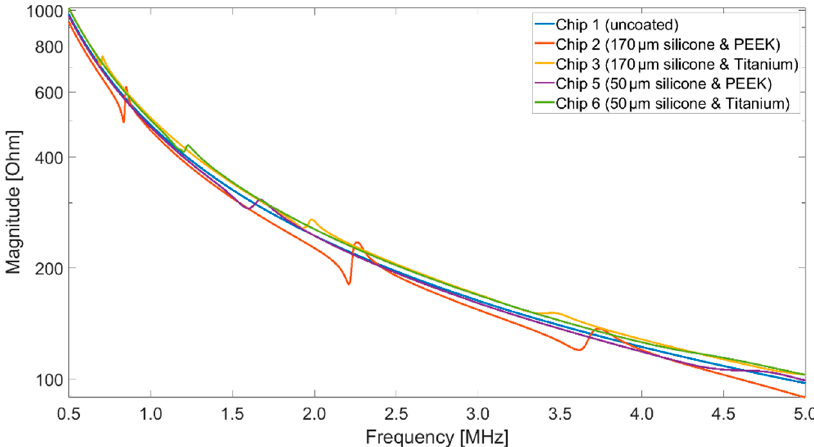
Figure 8. Electrical impedance in air for uncoated CMUT chips and for those covered with silicone and foil, 40 V DC .